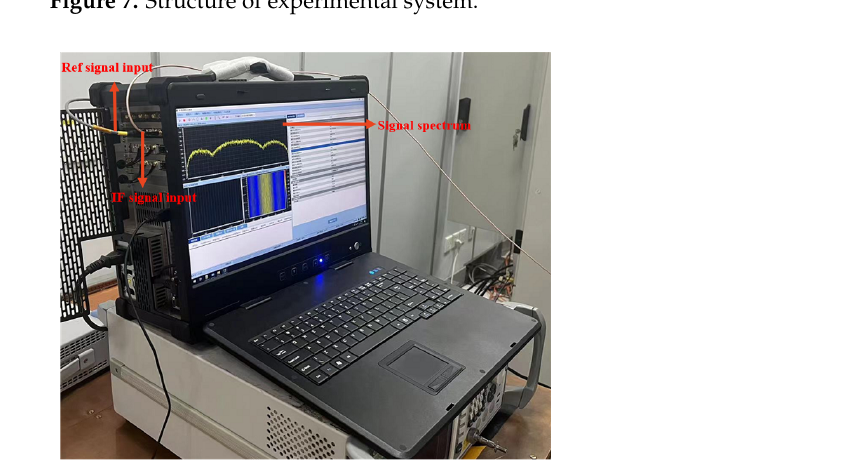
Figure 7. Structure of experimental system.